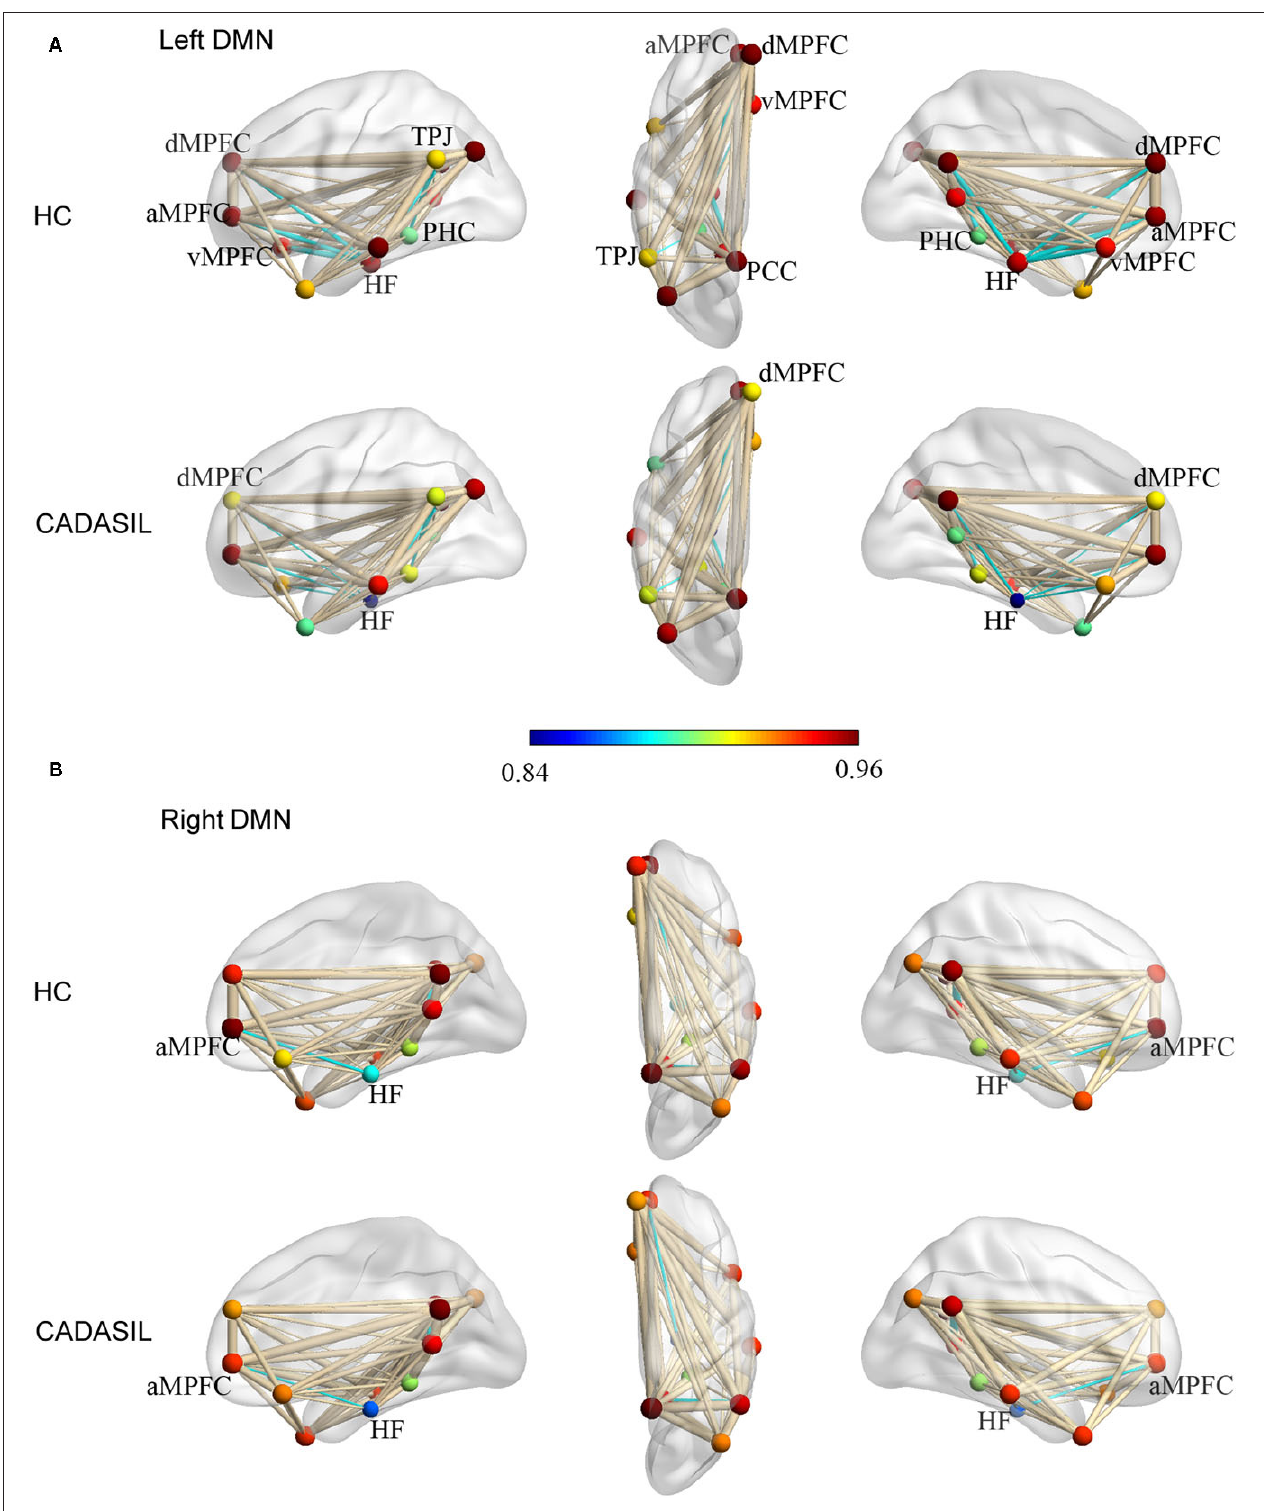
FIGURE 1 | Topological properties of DMN in CADASIL and control groups in the left (A) and right (B) hemisphere. The color bar corresponded to nodal color, representing the mean nodal efficiency in the corresponding group. Nodal size represented the mean degree of centrality in the corresponding group. The thickness of edges reflected the strength of FC between regions. FC showing significant differences between the two groups was indicated in cyan ( p < 0.05). DMN, default mode network; CADASIL, cerebral autosomal dominant arteriopathy with subcortical infarcts and leukoencephalopathy; FC, functional connectivity; HC, healthy